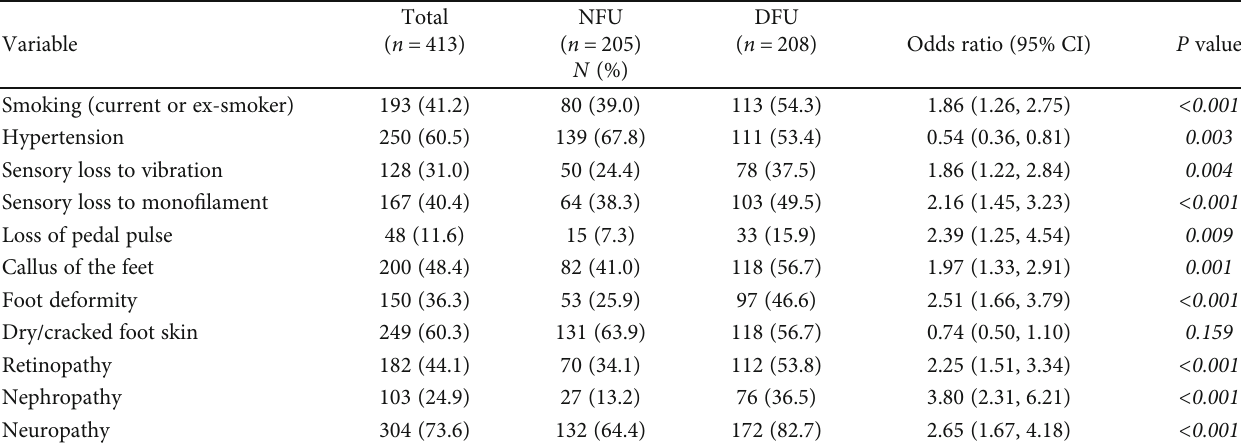
Table 3: Comparison of risk factors between DFU (diabetic patients with foot ulceration) and NFU (diabetic patients without foot ulceration).